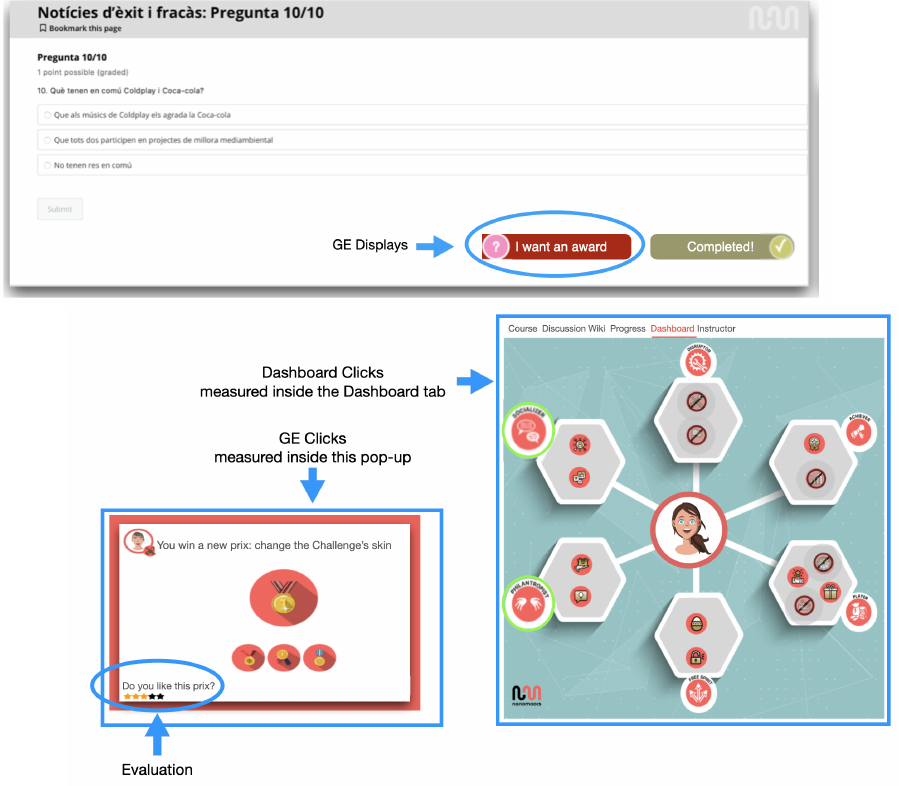
Figure 5. Top: GE Displays are collected using clicks on the button I want an award . Bottom left: GE Clicks are monitored using clicks on the GE, while Evaluations refer to the scorings of each displayed game element using stars. Bottom right: Dashboard Clicks refer to those clicks made in the dashboard